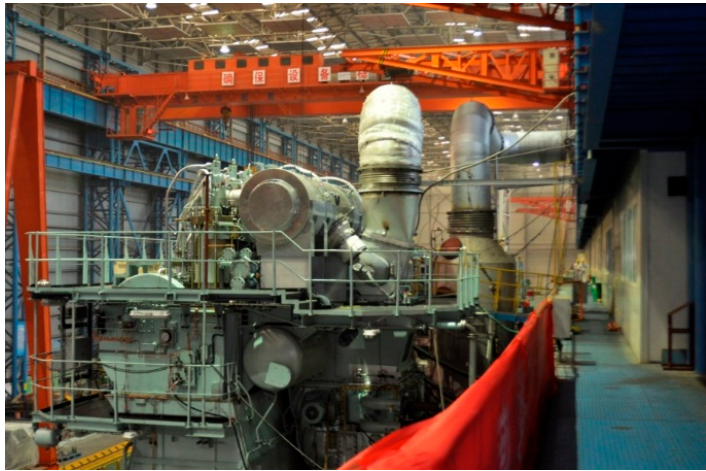
Figure 2. Photograph of the experimental setup for the scrubber in a marine diesel engine.